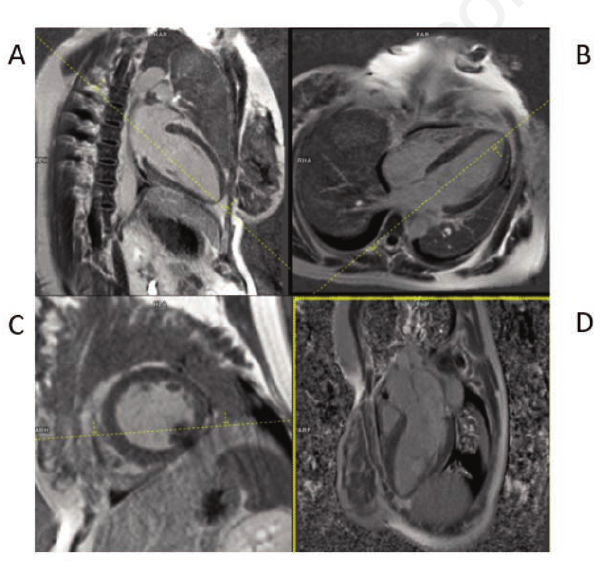
Figure 2. T2 mapping showed no evidence of myocardial edema and bilateral pleural effusion (right>left). A) 2-chamber long axis; B) 4-chamber long axis; C) short axis at the level of the pap- illary muscles; D) 3-chamber long